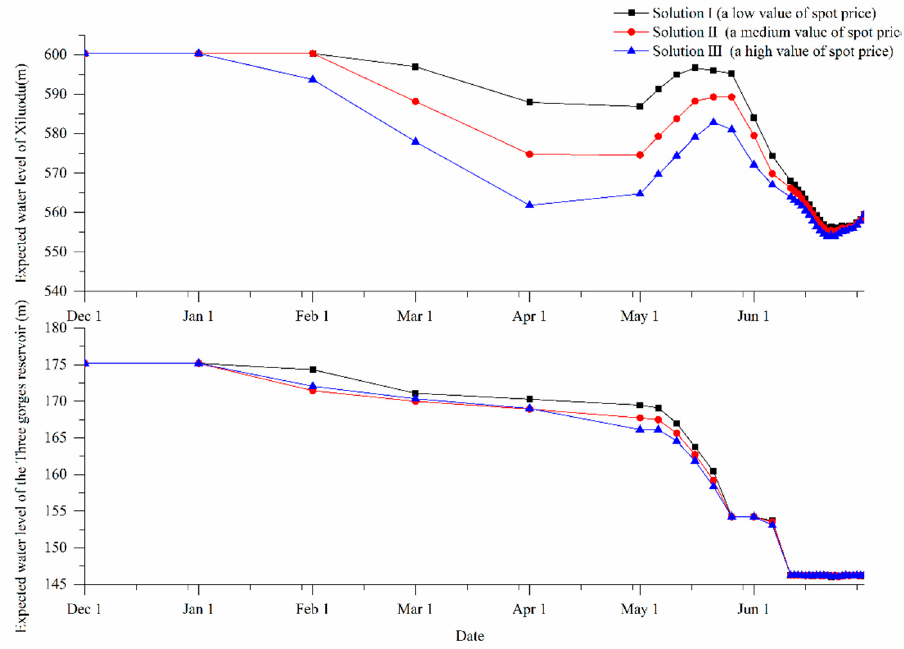
Figure 4. Expected variations in water levels of Xiluodu and the Three gorges reservoir.